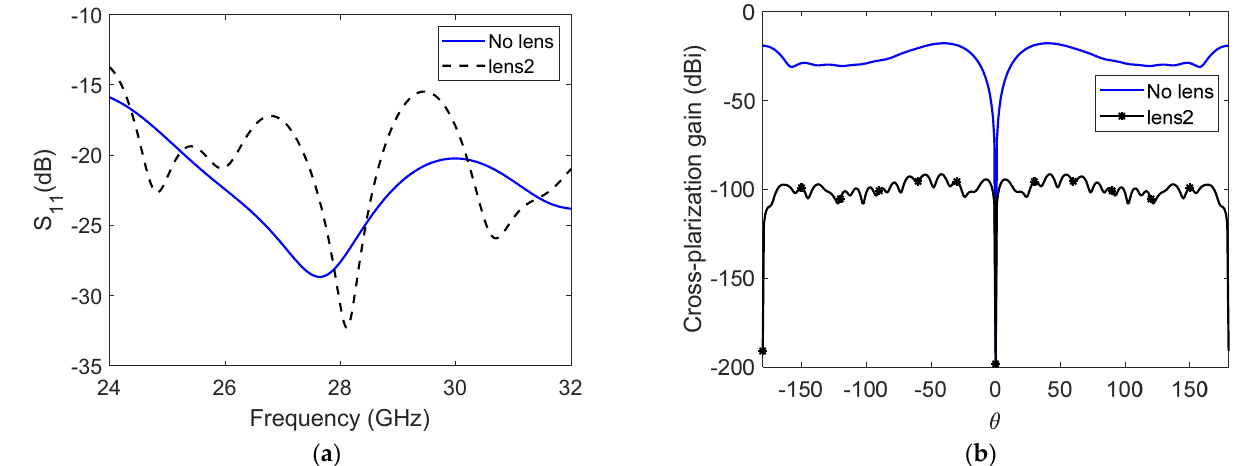
Figure 5. ( a ) The reflected scattering parameter and ( b ) cross ‐ polarization gain.